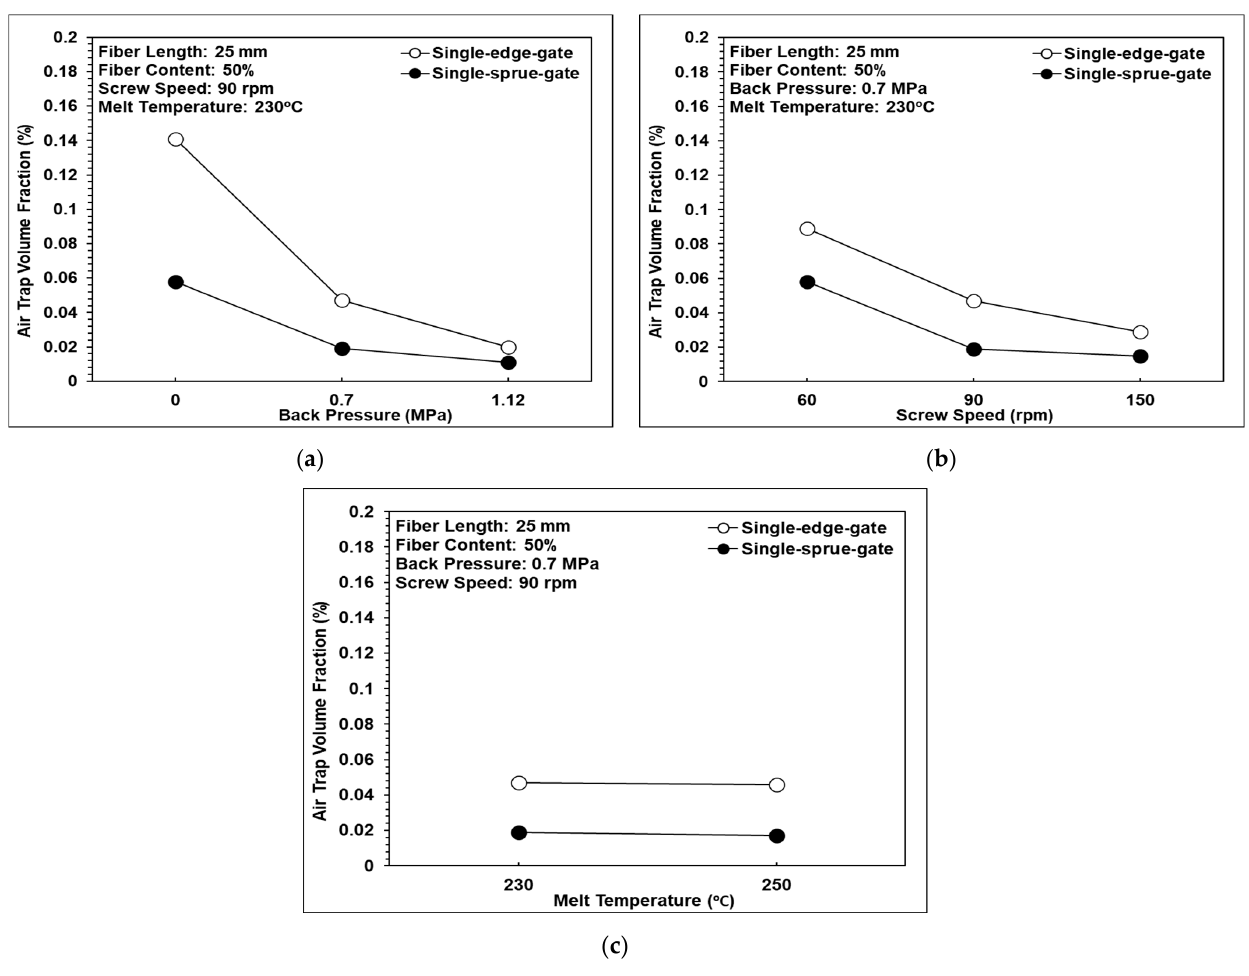
Figure 15. Effects of the different melt flow paths on the air trap volume fraction: ( a ) back pressure variations, ( b ) screw speed variations, and ( c ) melt temperature variations.